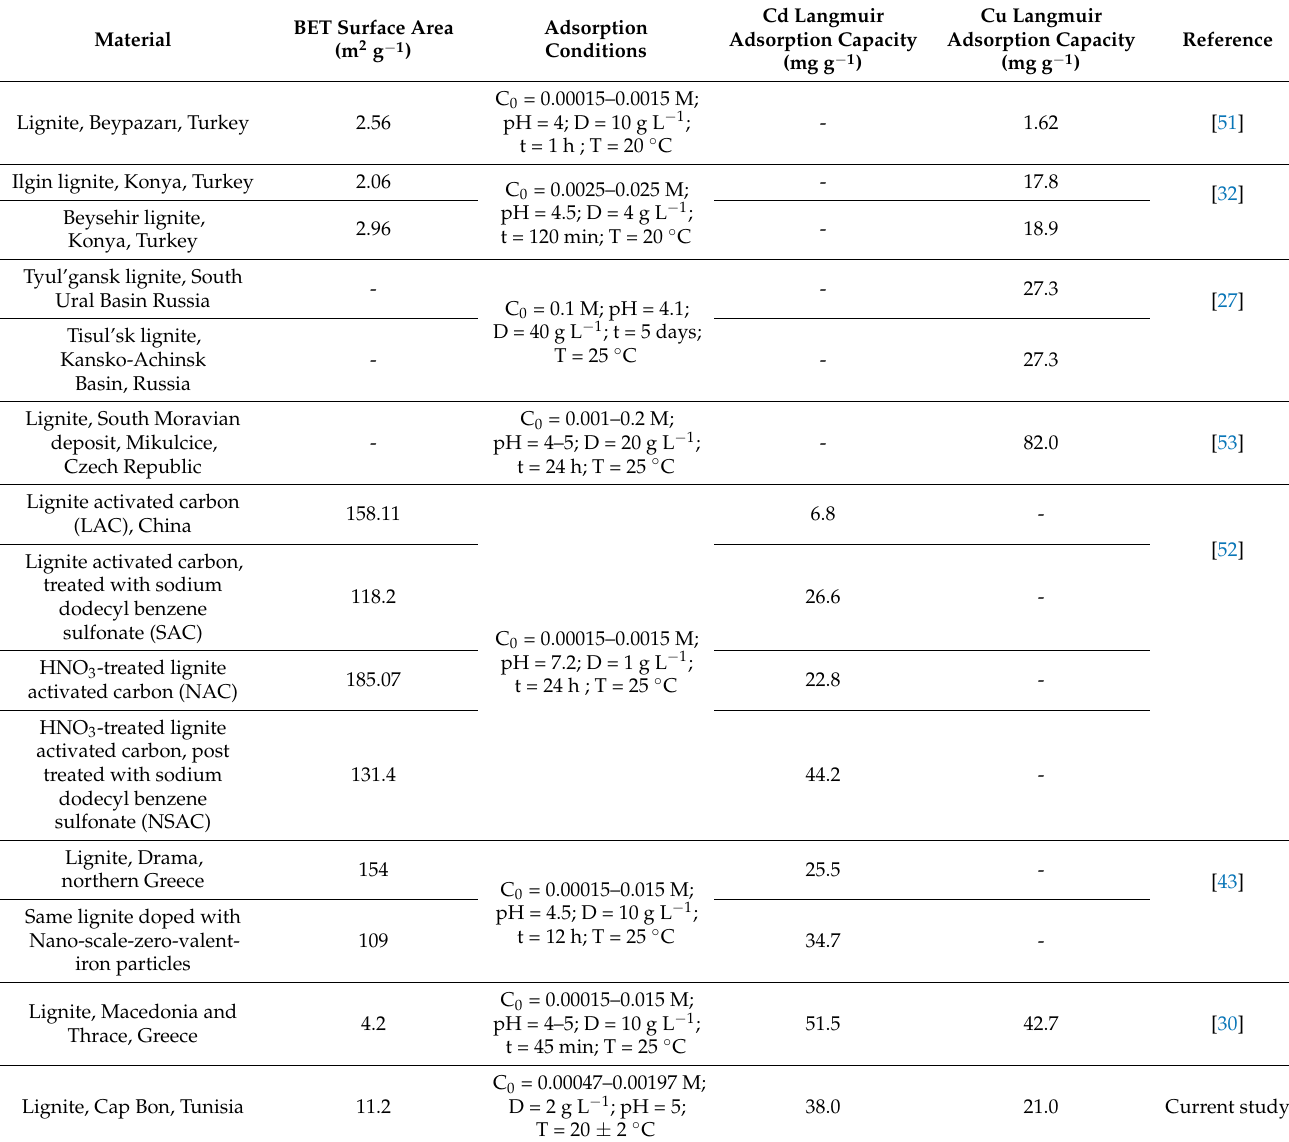
Table 3. Comparison of the used lignite removal efficiency of Cd and Cu with other lignites from various regions.